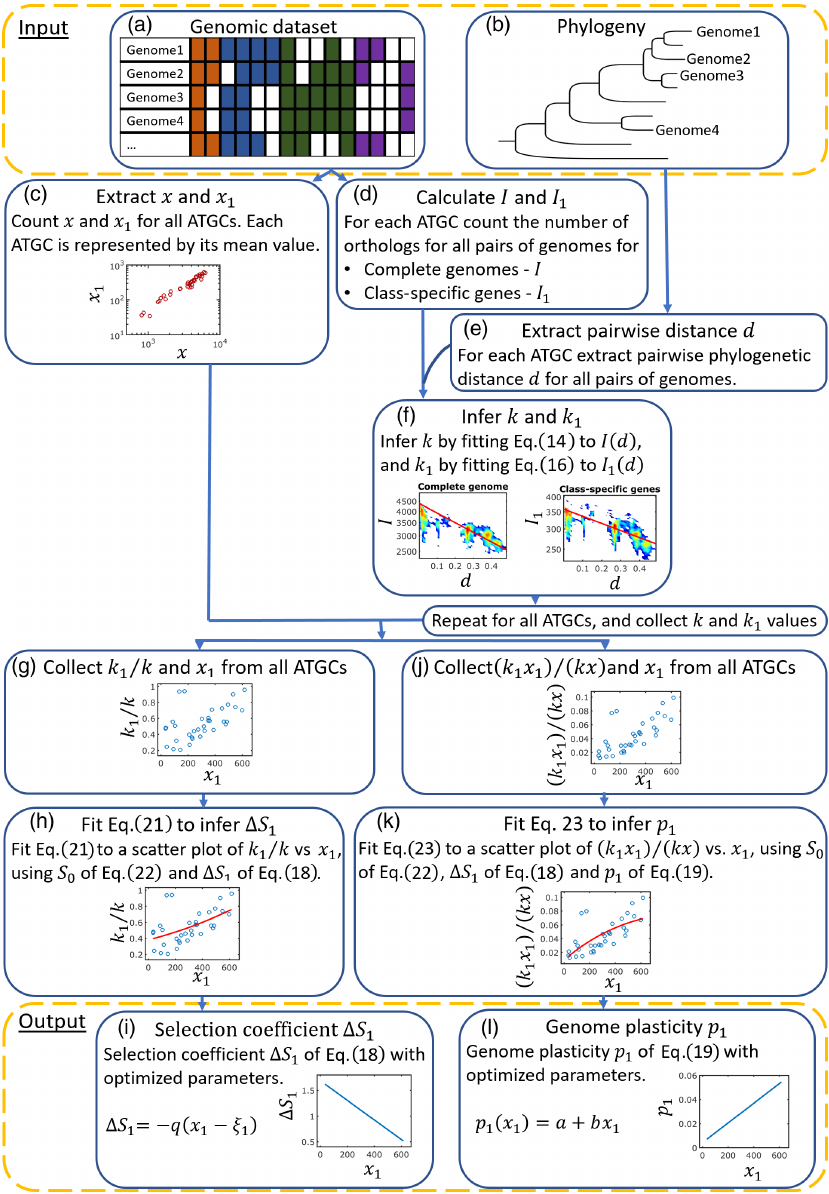
FIG. 3. Graphical visualization of the analysis for a single functional class. This figure illustrates the stages of the model parameters inference scheme from the genomic data starting from the input of the genomic data (Sec. II A) to the output of the fitted model parameters of Eqs. (18) and (19). (a) Visualization of the dataset used as the model input. A representation of four genomes from a single cluster of genomes (ATGC) is shown. The genomic data can be represented as a table where each row corresponds to a genome and each column corresponds to a gene. Colored entries indicate presence of a gene in a genome, and different colors indicate different functional classes of genes. (b) The evolutionary relationships between the genomes are represented by a phylogenetic tree. (c) The total number of genes and the number of class-specific genes are extracted for each ATGC. Each ATGC is represented by a circle, where the x 1 and x values for each ATGC are taken as the mean values for all genomes in the ATGC. (d) For each ATGC, the number of common orthologs is counted for all genome pairs, both for all genes, and for functional classes of genes. (e) For all genome pairs, the evolutionary distance is inferred from the phylogenetic tree shown in (b). (f) Decay constants of genome intersections with evolutionary distance k and k 1 are inferred from the genomic data by fitting the model to observed decays of I or I 1 (model fits are shown by red lines). The genomic data are shown by a heat map [see the legend to Fig. 5(a) for details]. (g) The analysis described in (f) is performed for all ATGCs to capture the dependence of the k 1 =k ratio on x 1 . Each point in the scatter plot represents a single ATGC, where the representative x 1 value for an ATGC is taken as the mean value from all genomes in the cluster. (h) Inference of Δ S 1 by fitting Eq. (21) to the data of (g). The data are shown by circles, and the fitted analytical curve is shown by a red line. (i) Inferred Δ S 1 . (j) The same as (g), but the ratio ð k 1 x 1 Þ = ð kx Þ . (k) Inference of p 1 by fitting Eq. (23) to the data of (j). The data are shown by circles, and the fitted analytical curve is shown by a red line. (l) Inferred p 1